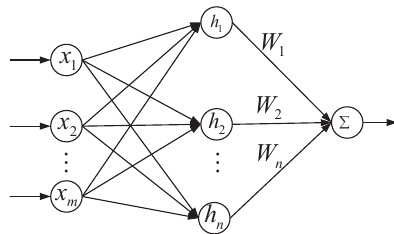
Fig. 3 The schematic diagram of the RBFNN Figure 3. The schematic diagram of the